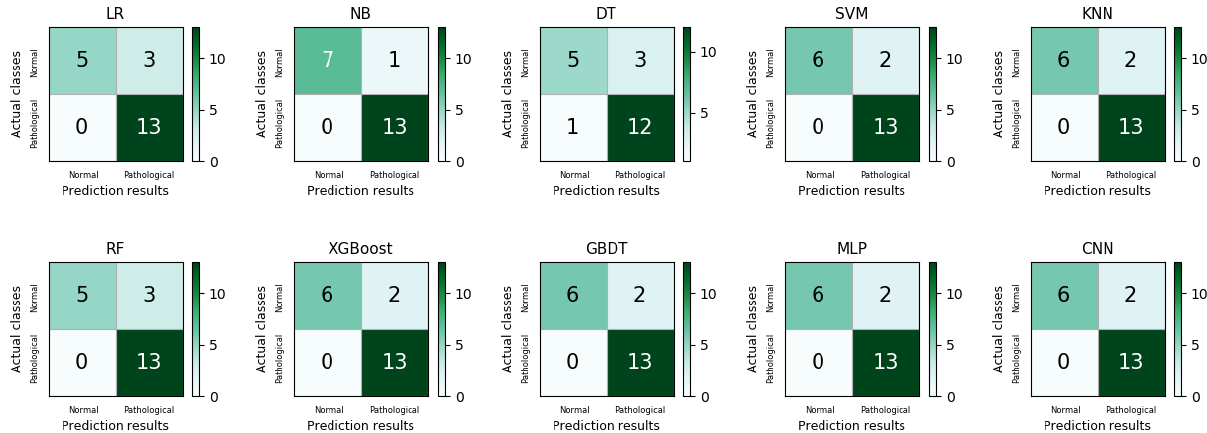
Figure 6. The binary classification confusion matrices of LR, NB, DT, SVM, KNN, MLP, and RF in the initial class- imbalanced